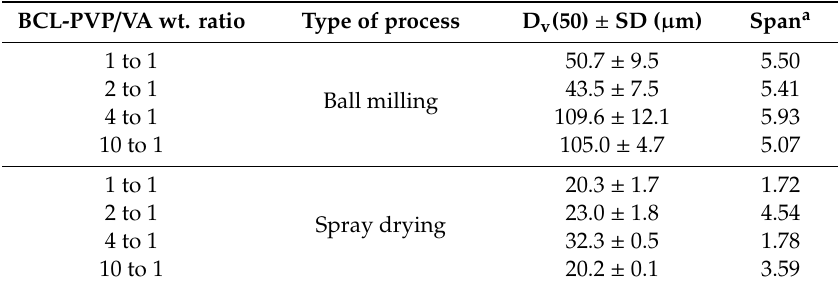
Table 2. Particle size of solid dispersions obtained using the laser diffraction method.